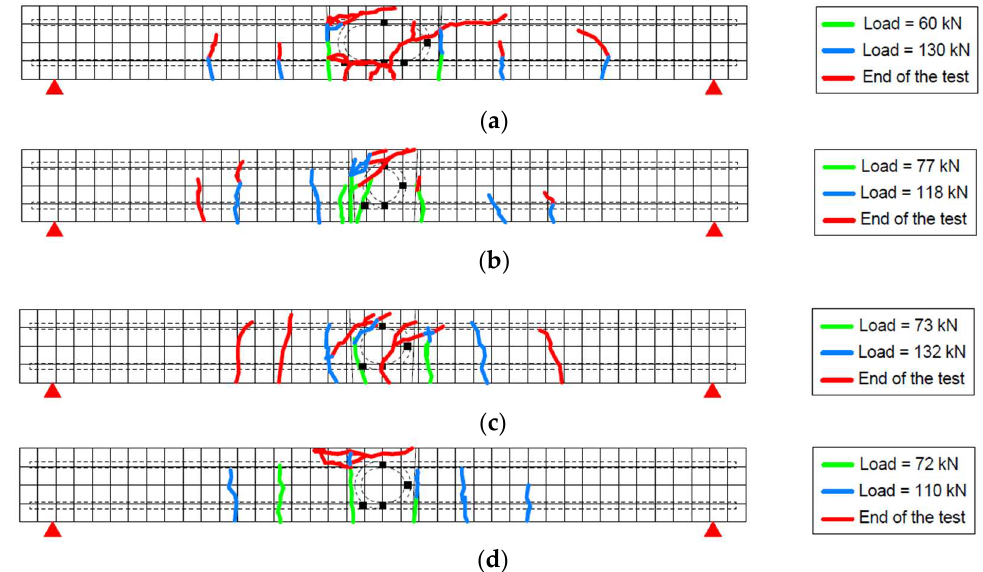
Figure 10. Crack distributions on South side of specimens ( a ) Type A; ( b ) Type B; ( c ) Type C; ( d ) Type D.